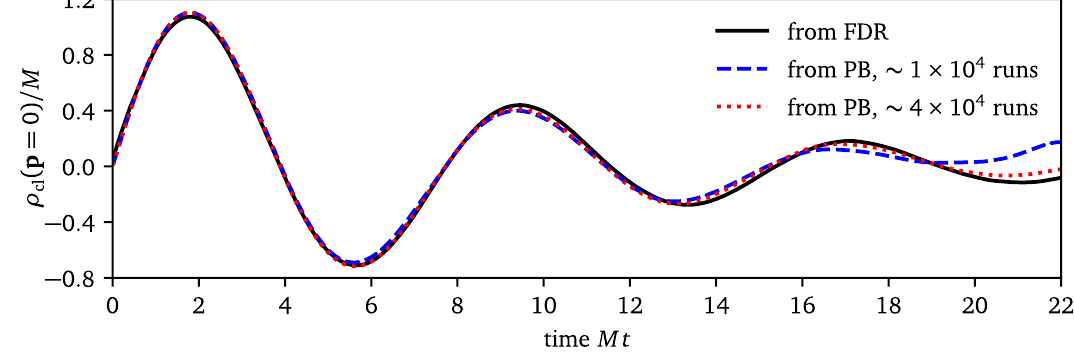
Figure 8: Comparison of two different numerical approaches to obtain the spec- tral function. Spectral function at zero momentum for G = 20 as obtained from the fluctuation-dissipation relations (FDR) (Eq. (7)) and the Poisson Bracket (PB) (Eq. (8)), where the former is fully converged with respect to the number of runs. The latter converges to the FDR result as the number of runs is increased. Deviations at early times are due to the finite time step (see